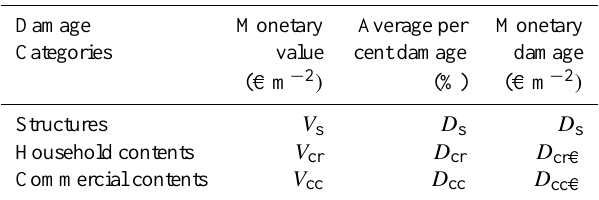
Table 1. Summary of the damage categories considered and their